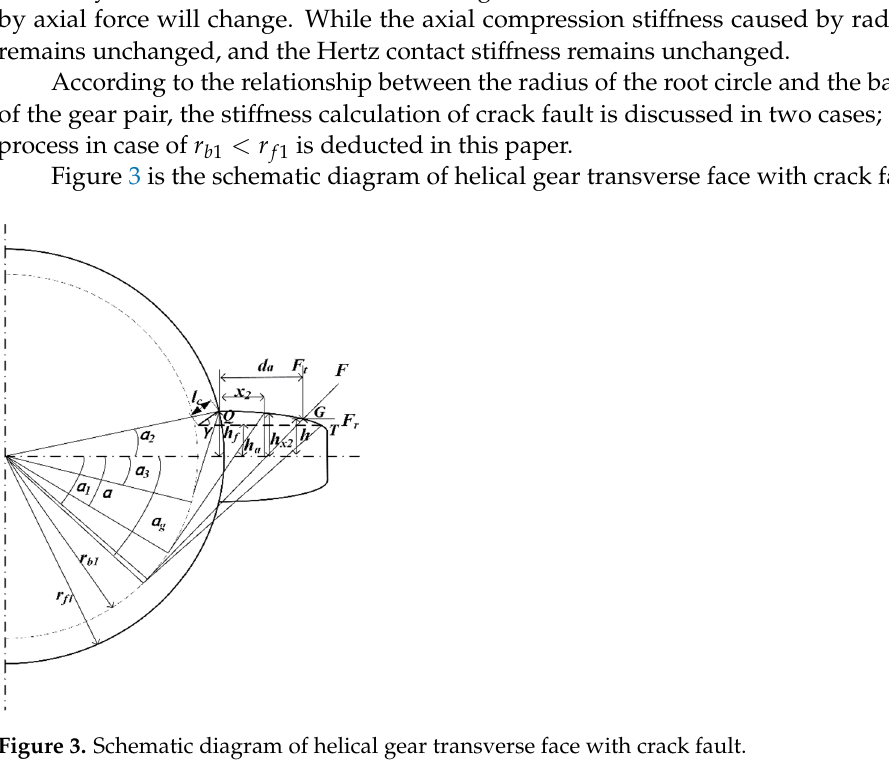
Figure 3. Schematic diagram of helical gear transverse face with crack fault.